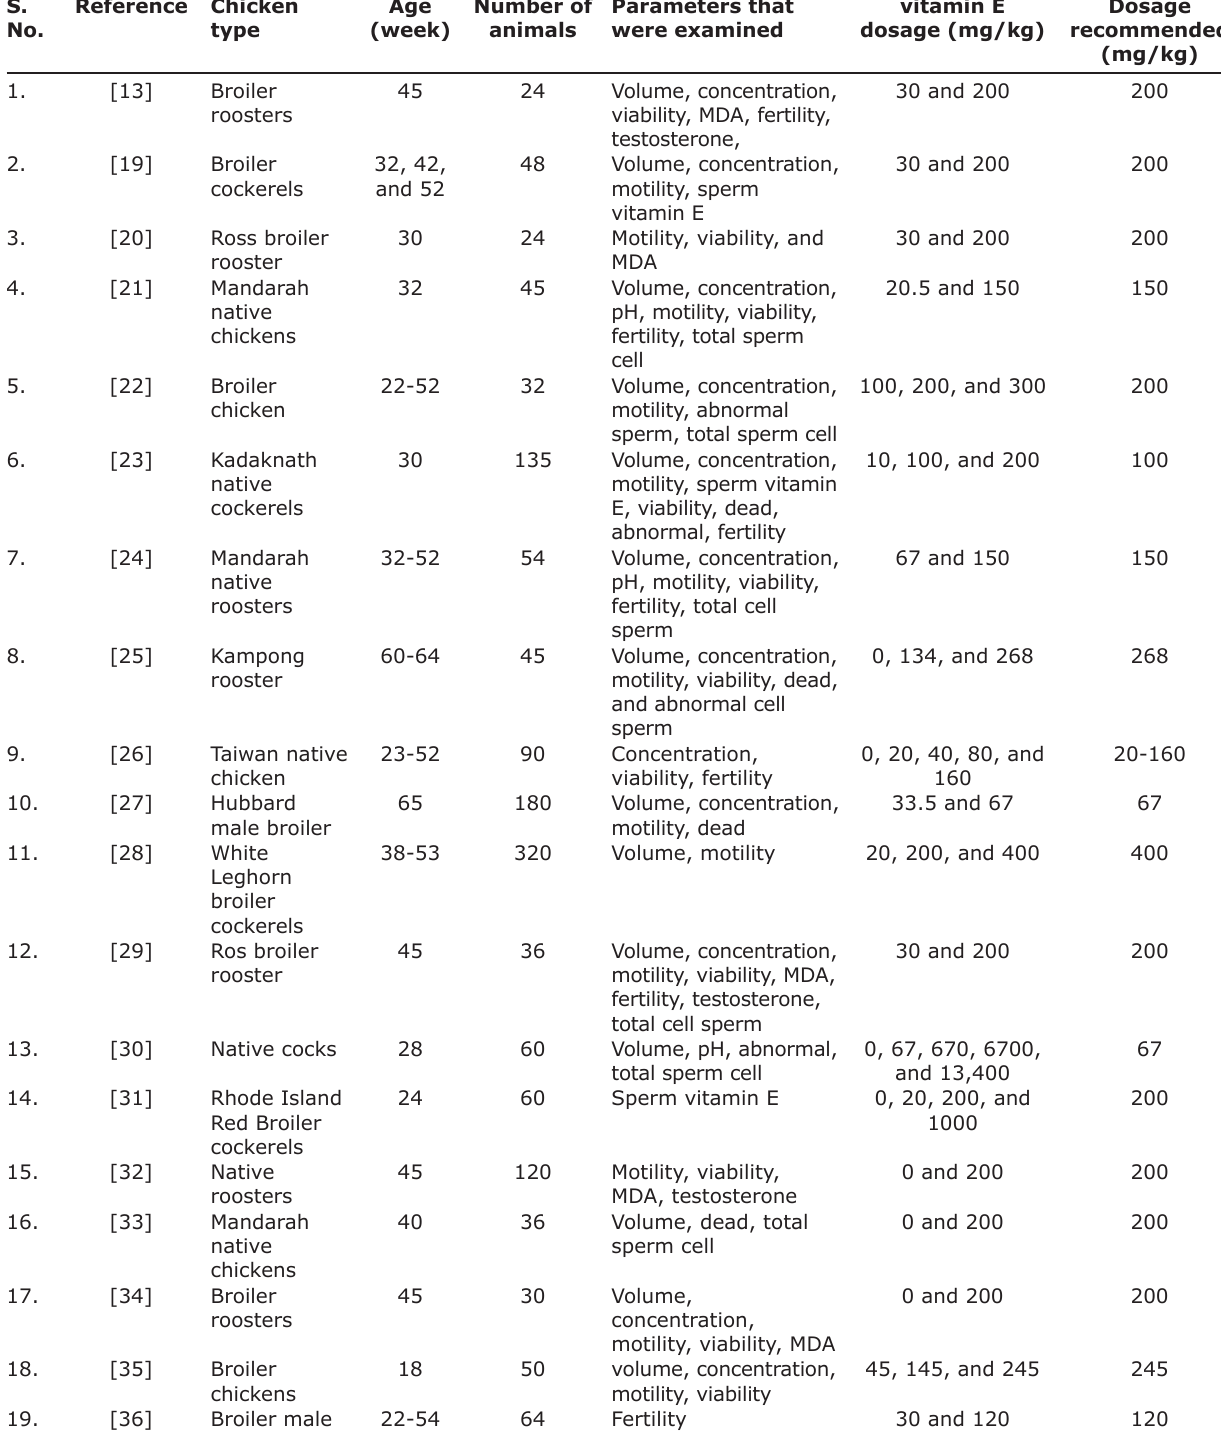
Table-1: Studies included in the meta-analysis. S.